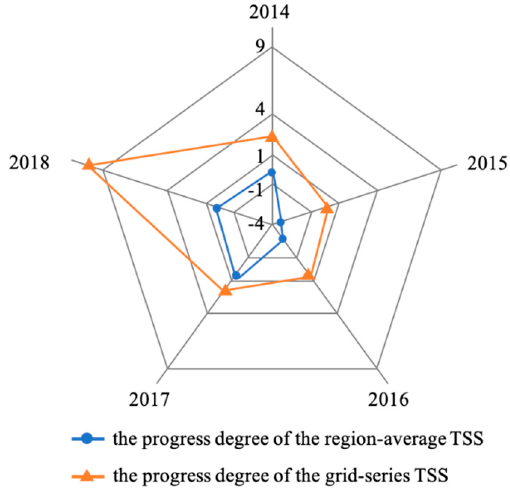
Figure 11. The evaluation results of the progress degree of TSS in the Shijiao Town area of Hedi Reservoir from 2014 to 2018. The blue part is based on the region-averaged TSS concentration in the Shijiao Town area, and the orange part is based on the pixel-based TSS concentration in the Shijiao Town area.